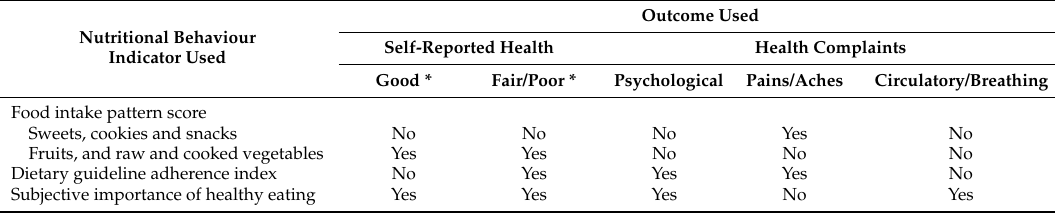
Table 6. Utility of different nutritional behaviour indicators for different levels of self-reported health and different health